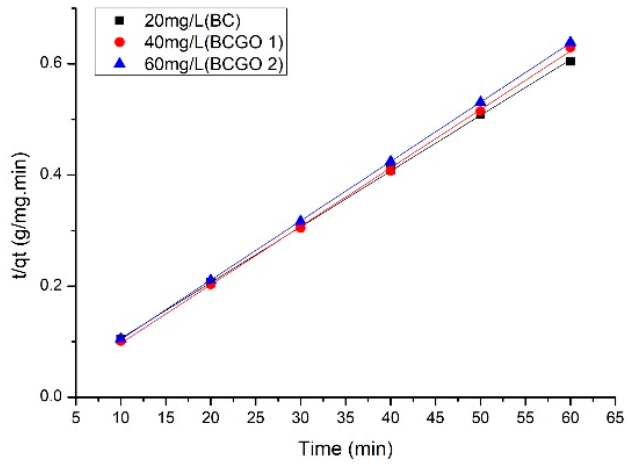
Figure 9. Pseudo-second-order (PSO) rate model plot of Pb(II) adsorption on to prepared samples. Parameters derived from the plots for Pb(II) adsorption are shown in Table 2. Table 2. Results of experimental kinetic data for adsorption of Pb 2+ onto BCGO materials.